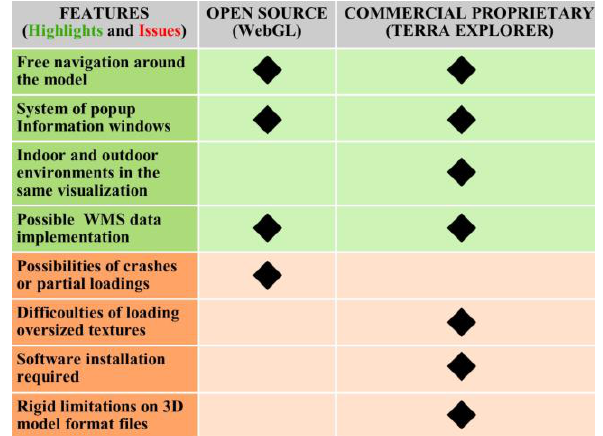
Figure 15. strengths and weaknesses of open-source